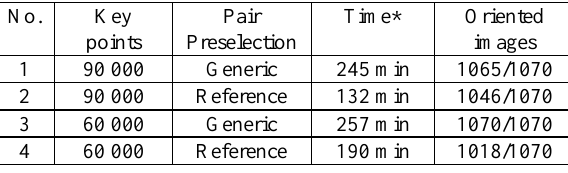
Table 1. Time and effectiveness of orientation in Agisoft